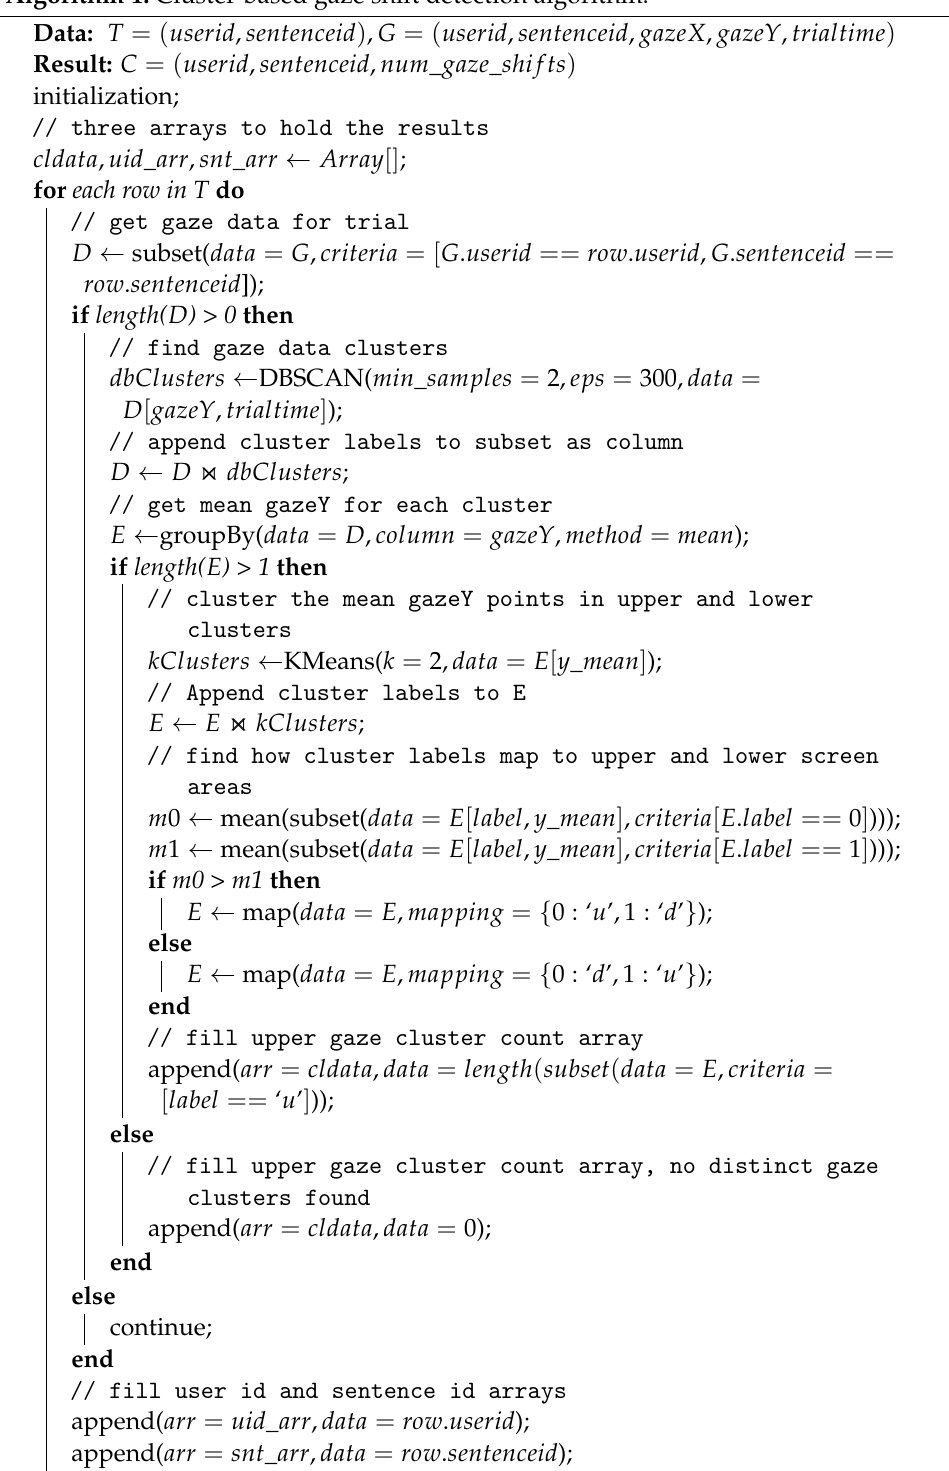
Algorithm 1: Cluster-based gaze shift detection